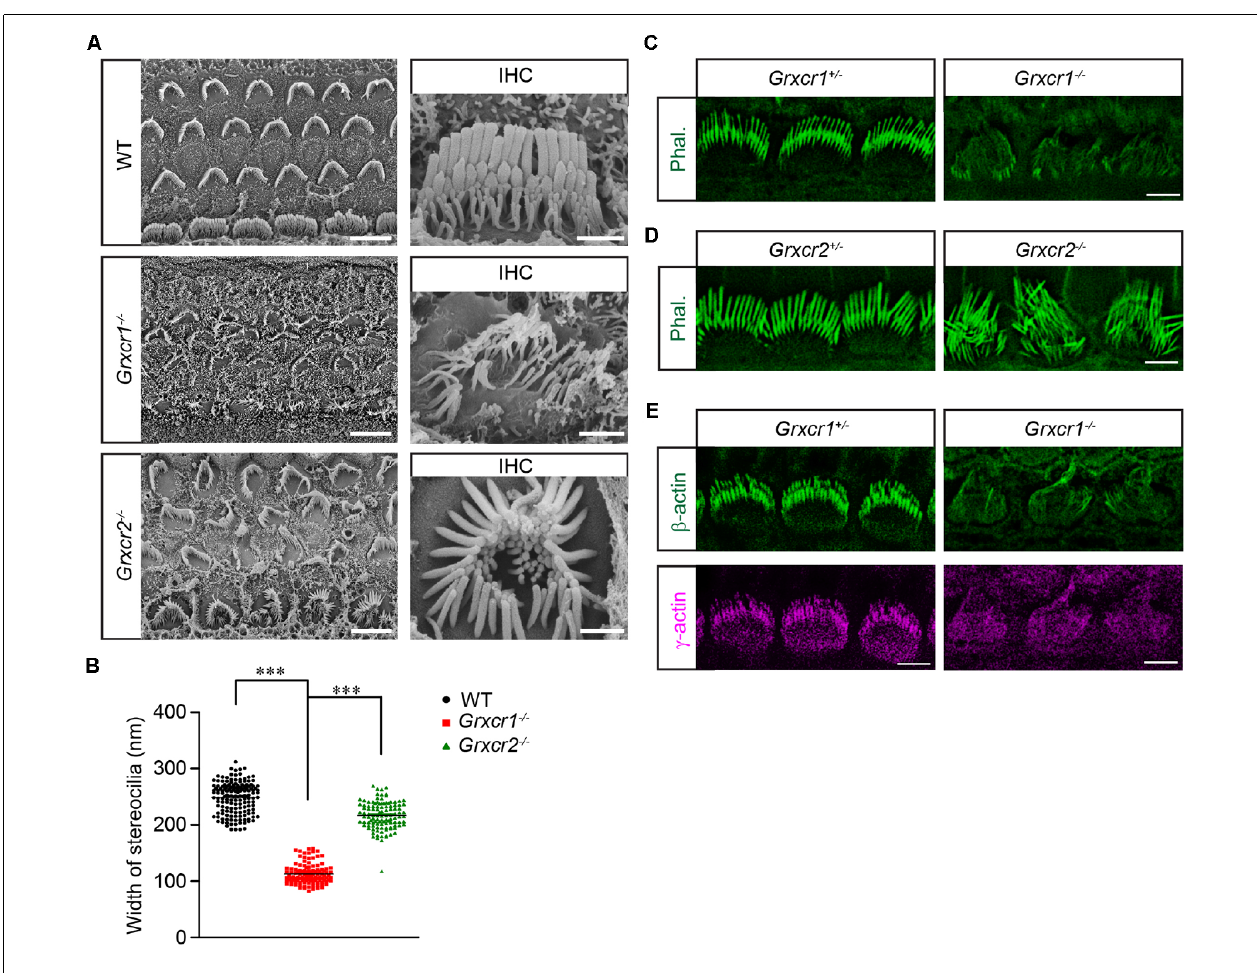
FIGURE 1 | Stereocilia morphology in Grxcr1 -deficient hair cells. (A) Scanning electron microscope images showing auditory epithelia of wild-type, Grxcr1 − / − , and Grxcr2 − / − mice at the age of P7. Stereocilia of inner hair cells (IHCs) and outer hair cells (OHCs) from Grxcr1 − / − and Grxcr2 − / − hair cells were disorganized. Note, stereocilia in Grxcr1 − / − hair cells were extremely thin. Scale bars: left, 5 µ m; right 1 µ m. (B) Width of the tallest row of stereocilia of IHCs from wild-type, Grxcr1 − / − , and Grxcr2 − / − mice at the age of P7. All values are represented as the mean ± SEM. ∗∗∗ p < 0.001 by Student’s t test. (C,D) Cochlear whole mounts from Grxcr1 − / − (C) and Grxcr2 − / − (D) mice at P7 were stained for phalloidin to reveal stereocilia. Note the weak phalloidin staining signal in Grxcr1 − / − IHCs. Scale bars: 5 µ m. (E) Cochlear whole mounts from Grxcr1 − / − mice at P7 were stained for β -actin and γ -actin. Scale bars: 5 µ m.